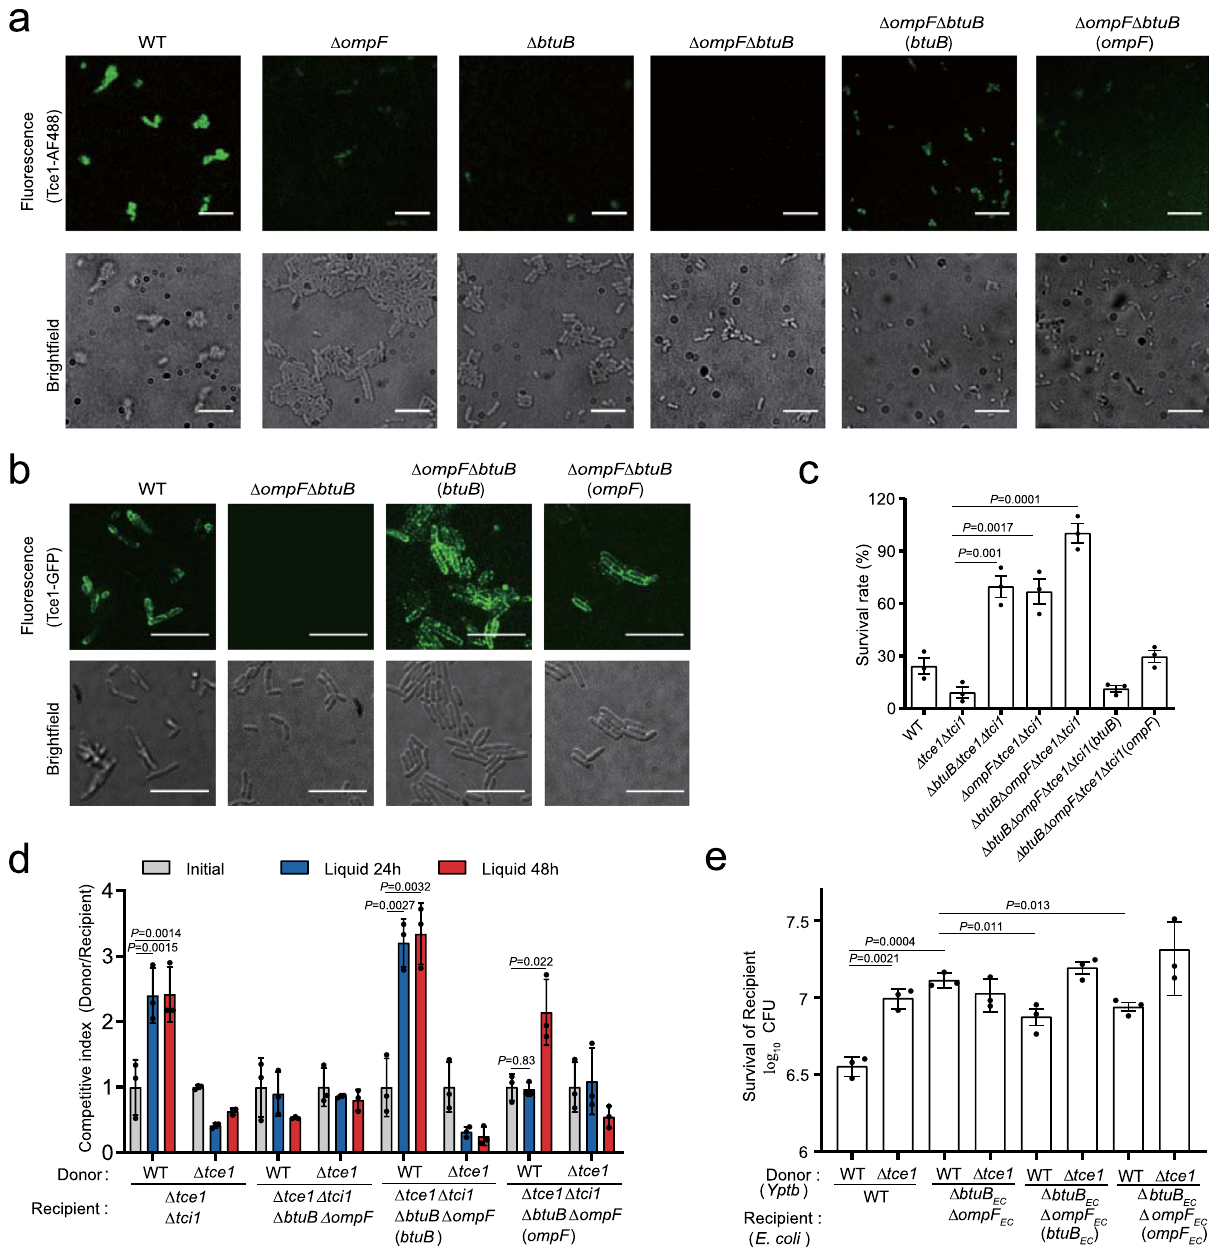
Fig. 4 Tce1 requires BtuB and OmpF for target cell entry. a , d Fluorescence labeling of the indicated Yptb strains with Tce1-AF488 ( a ) or GFP-Tce1 ( b ). Note that the Δ btuB Δ ompF mutant shows no labeling, while WT Yptb and complemented strains are labeled in both assays (scale bars, 20 μ m). Quanti fi cation of a and b was shown in Supplementary Fig. 4c, d. c Toxicity assays of puri fi ed Tce1 protein to Yptb strains. The indicated Yptb strains were diluted 40-fold in M9 medium and treated with puri fi ed Tce1 (0.1 mg ml − 1 ) for 1 h, and the viability of cells was determined by counting the CFU after treatment. d Intra-species growth competition experiments between the indicated Yptb donor and recipient strains. Donor and recipient strains were mixed 1:1 and grown for 24 or 48 h in liquid medium at 26 °C. Bars represent the mean donor:recipient CFU ratios of three independent experiments (±SD). e Inter-species growth competition experiments between the indicated Yptb donor and E. coli DH5 α recipient strains. Donor and recipient strains were mixed 10:1, grown for 12 h in liquid medium at 26 °C. The survival of E . coli cells was quanti fi ed by counting CFUs on selective plates. Data are mean ± SD from three biological replicates. P -values from all data were determined using two-sided, unpaired Student ’ s t -test, and signi fi cant differences were considered as P <